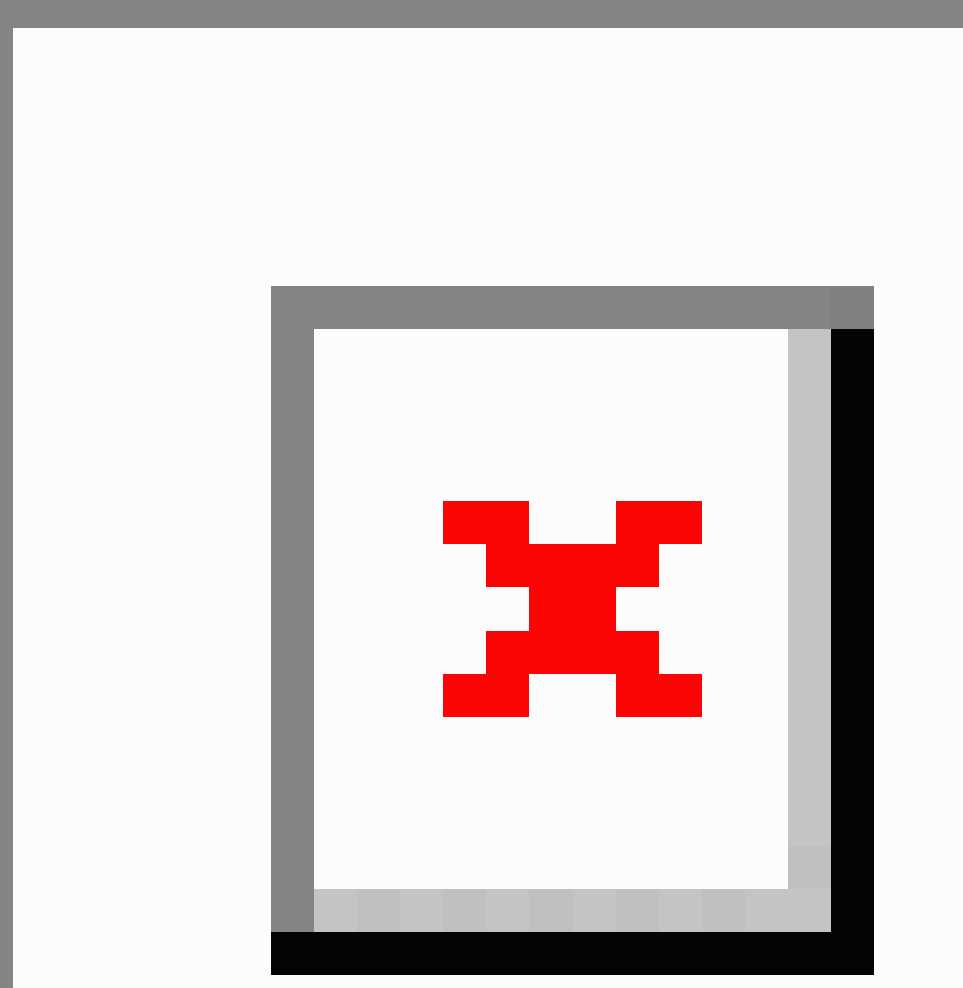
Figure 2. Sample medicine dosing algorithm (for a simple medicine–topical Clotrimazole